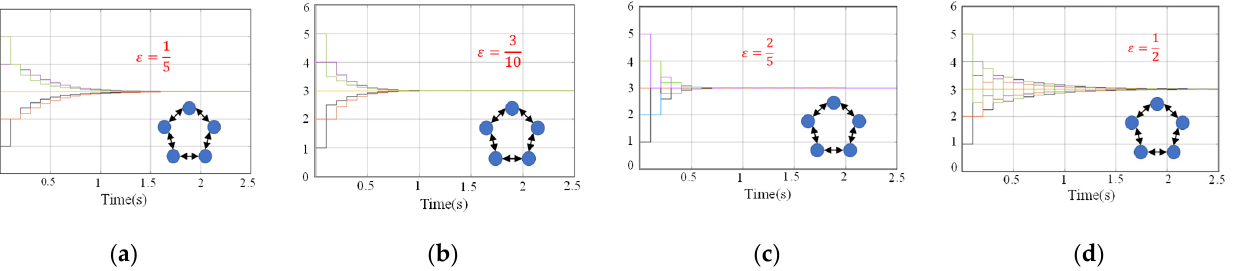
Figure 6. Comparison of convergence rates under different weights. ( a ) ε = 0.2; ( b ) ε = 0.3; ( c ) ε = 0.4; ( d ) ε = 0.5.